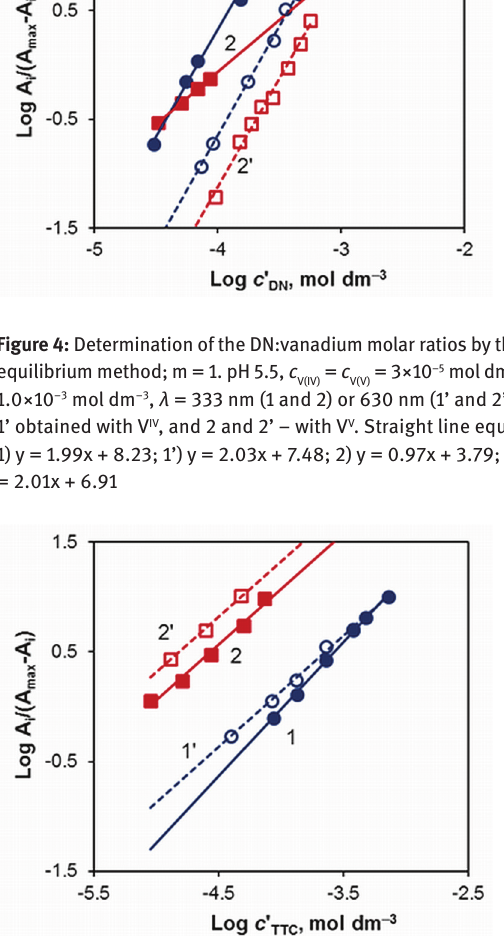
= c = 3×10 −5 mol dm −3 , c = V(IV) V(V) ND